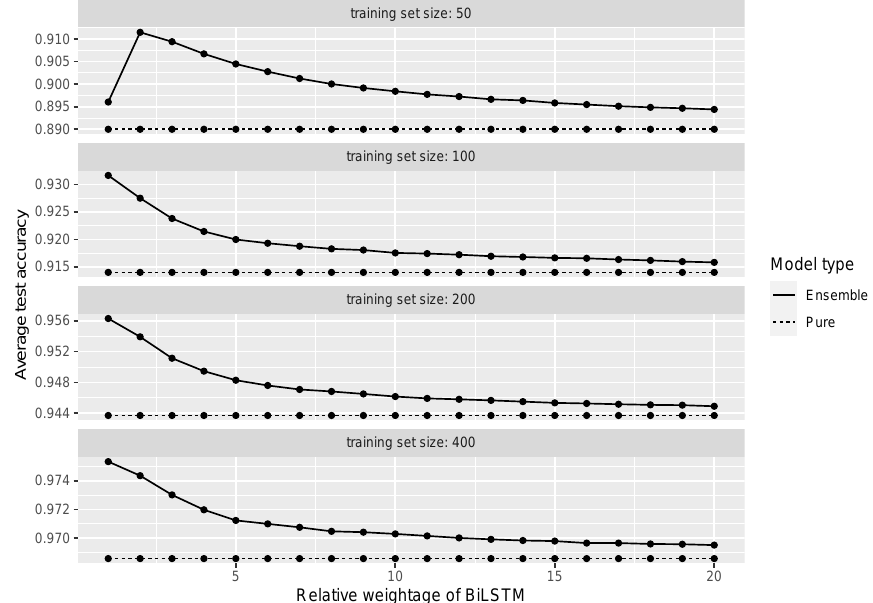
Figure 8. Average test accuracy of BiLSTM and TDA ensembles. The horizontal line is the accuracy of the pure BiLSTM model given as a reference.